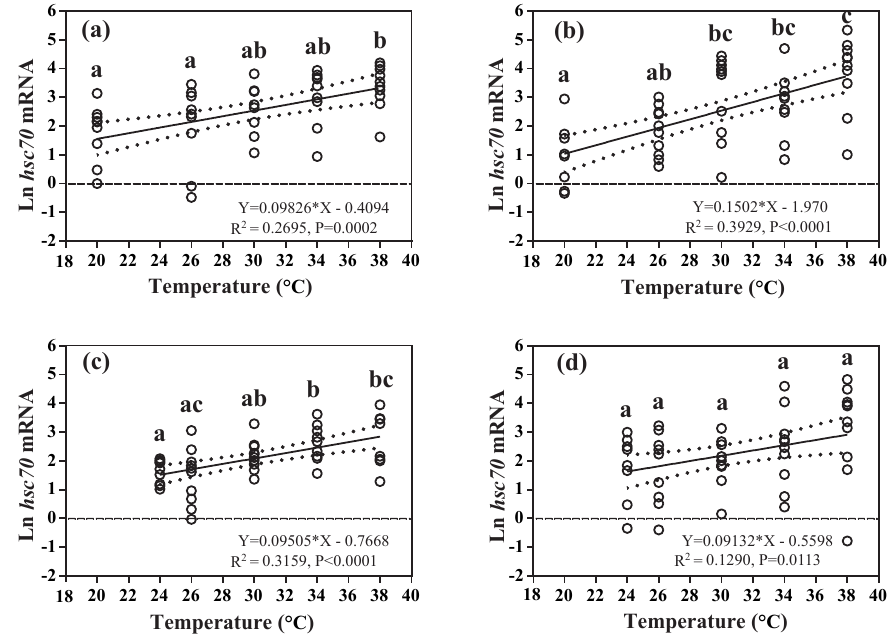
Figure 4. Effects of heat-shock temperature on the expression of hsc70 mRNA in limpets acclimated at (a) 20 ◦ C and 400ppm, (b) 20 ◦ C and 1000ppm, (c) 24 ◦ C and 400ppm, and (d) 24 ◦ C and 1000ppm. The relationship between heat-shock temperature and log-transformed gene expression of hsc70 was fitted using linear regressions with 95% confidence intervals (dahs lines). Different letters represent significant differences in the level of hsc70 mRNA among different heat-shock